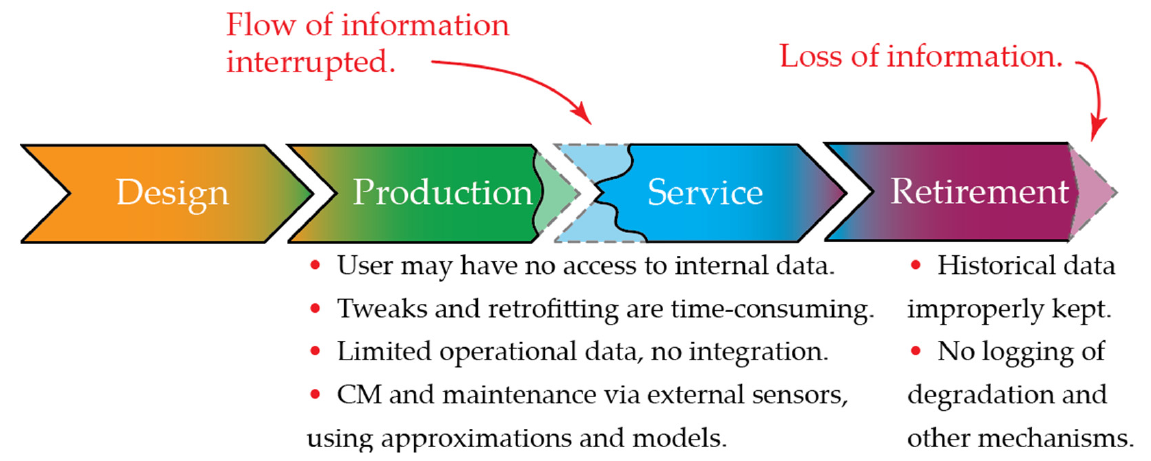
Figure 6. Illustration of data flow problems in the conventional product lifecycle.